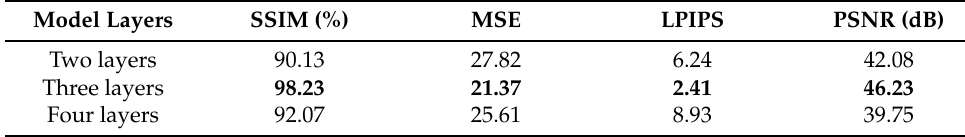
Table 3. Quantitative results with different